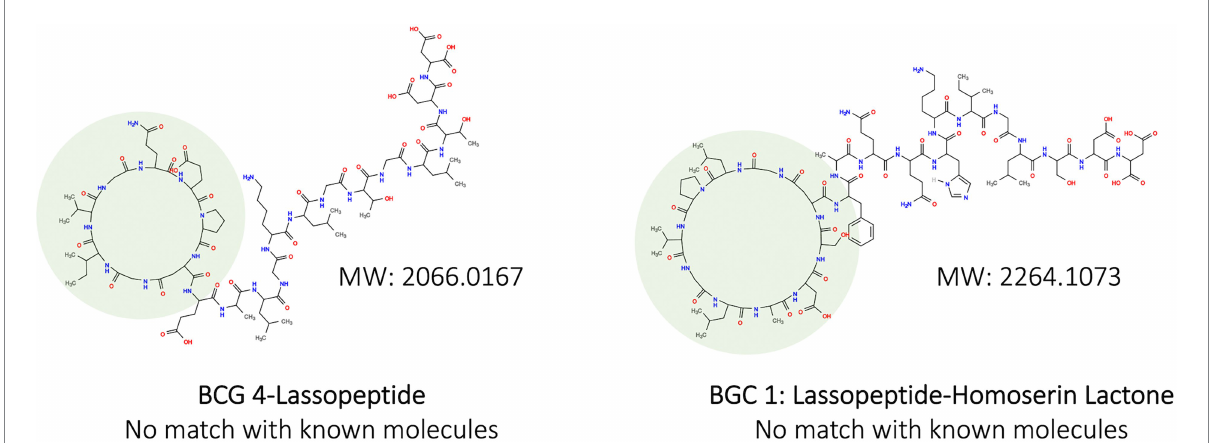
FIGURE 2 Predicted chemical structures produced by biosynthetic clusters in the genome of the Antarctic strain So64.6b based on PRISM detection. Macrocyclic ring formed by multiple N-terminal amino acid residues is highlighted in green. Remaining structure is the C-terminal tail of a lassopeptide. MW: molecular